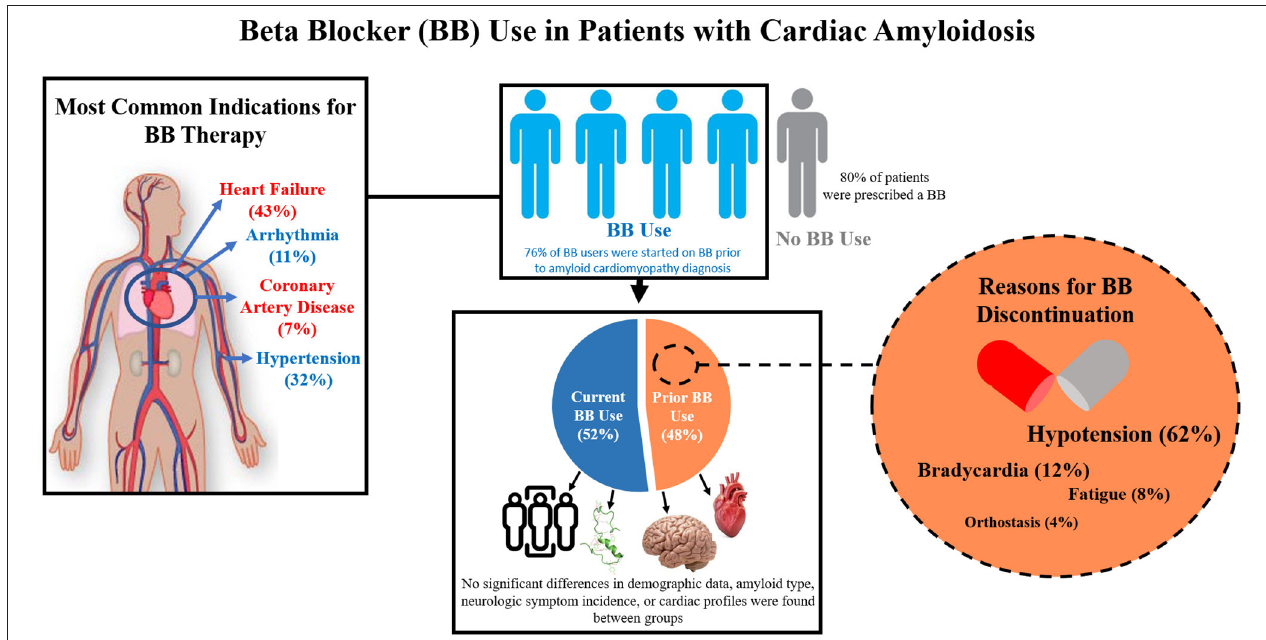
FIGURE 4 | Summary Figure. Beta-blocker use and tolerance were analyzed in a cohort of patients with confirmed amyloid cardiomyopathy in a large amyloidosis referral center in the United States. The most common indications for beta blocker (BB) therapy in our cohort included heart failure, hypertension, arrhythmia, and coronary artery disease. Most patients in our study cohort were prescribed a beta blocker (BB). Of these, over half of them were tolerating the therapy enough to remain on the medication. Between patient groups tolerating (Current BB Use) and not tolerating (Prior BB Use) BB therapy, no significant differences in cardiac profiles, neurologic symptom incidence, amyloid type, or demographic data exist. The most common reasons for BB discontinuation include hypotension, bradycardia, fatigue, and